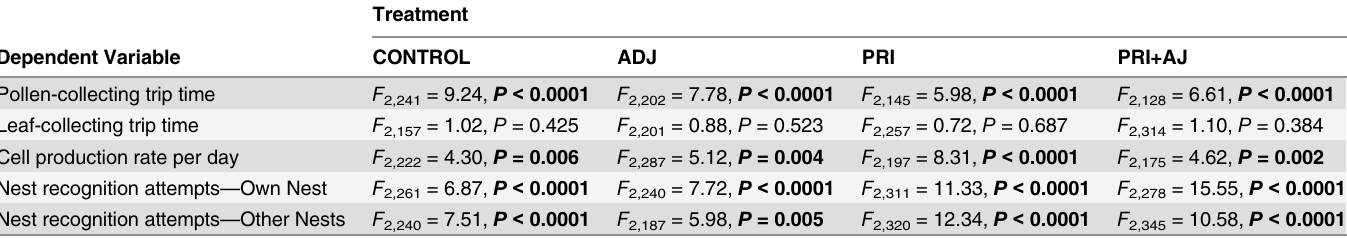
Table 4. ANOVA results for the treatment effects on the pollen-collecting trip time, leaf-collecting trip time, cell production rates per day, and the number of nest recognition attempts made to enter her own and other nests by Megachile rotundata females in cages in North Logan, Utah in